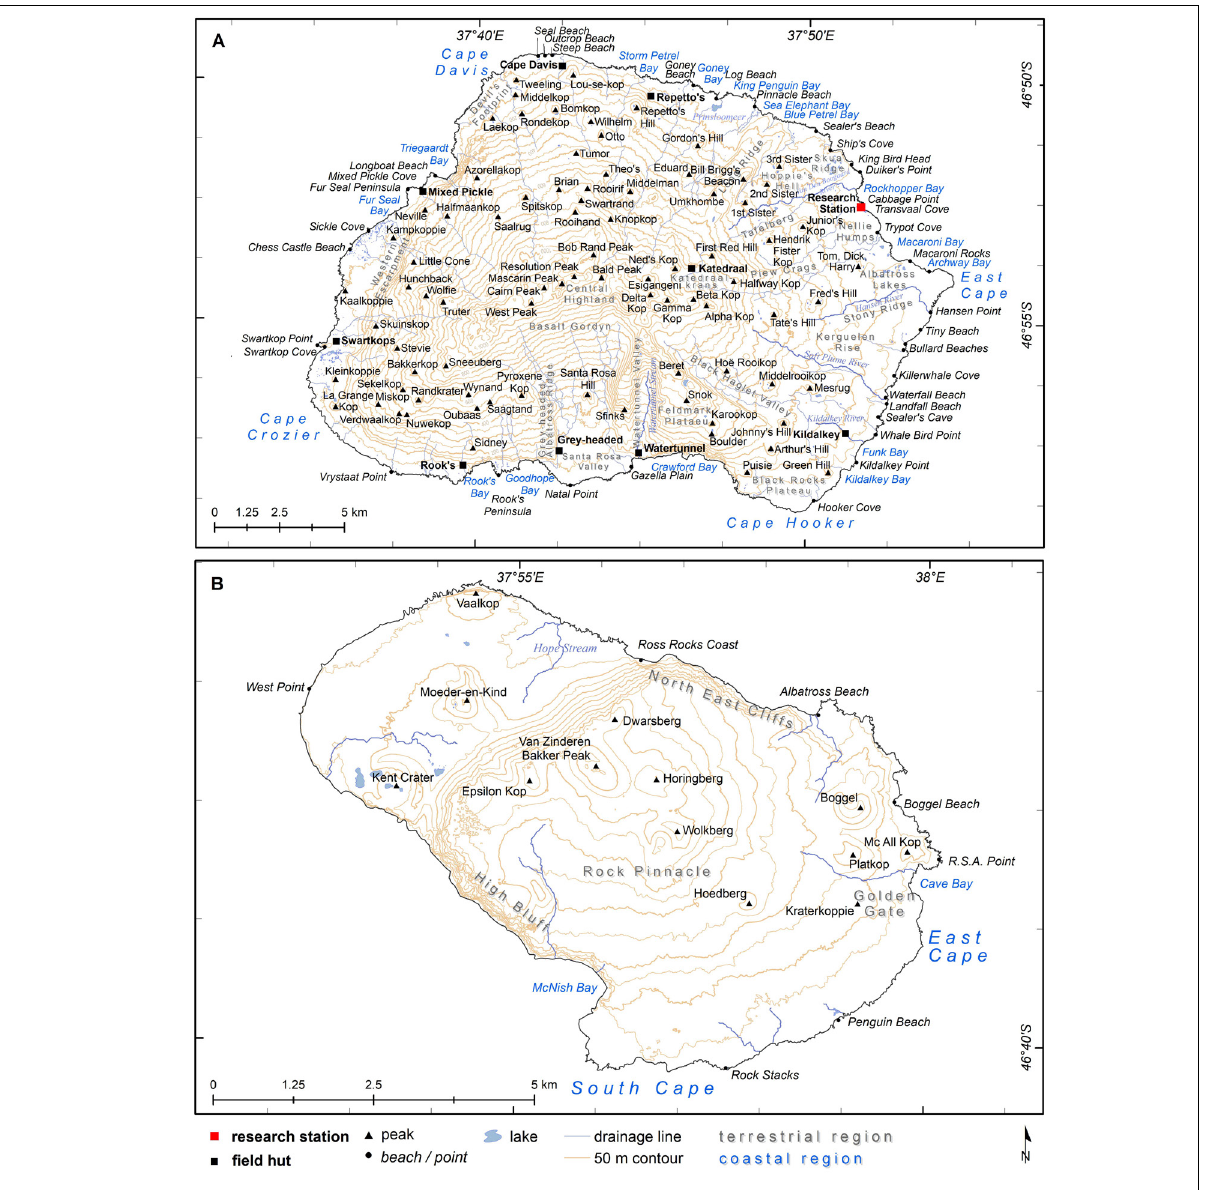
Figure 3: A preview of the topographical and hydrological data of (A) Marion Island and (B) Prince Edward Island which have been used to construct download maps of each (see Table 1). Refer to Supplementary tables 1 and 2 for the coordinates of these feature points. Projection: Transverse Mercator